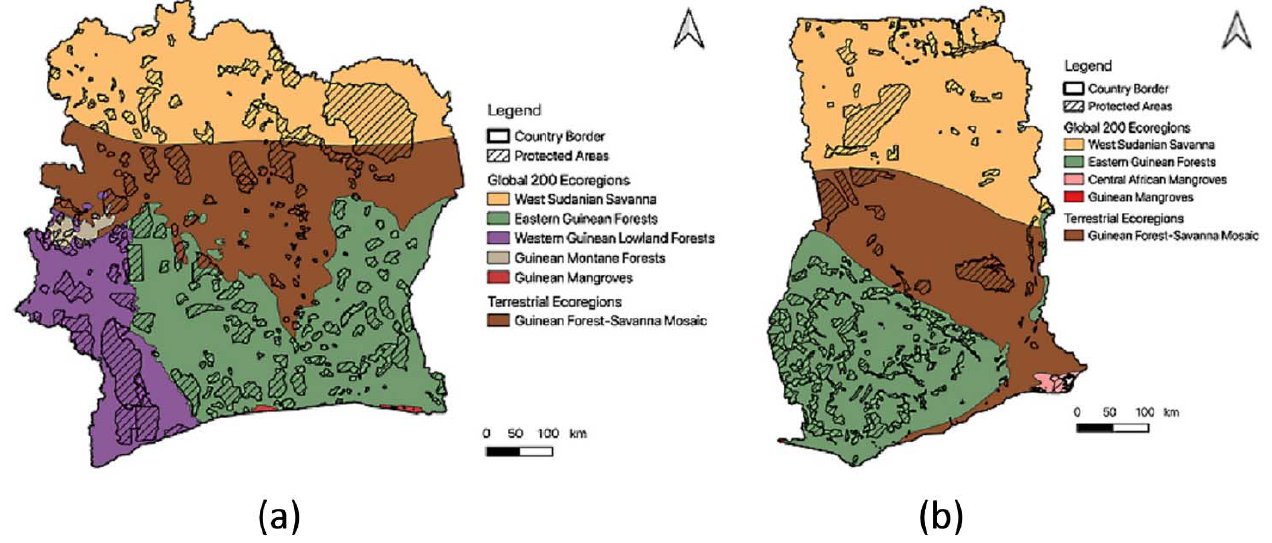
Figure 1. The ecoregions and protected areas of ( a ) Côte d’Ivoire and ( b ) Ghana, West Africa. Table 3. The comparison index (CI) for all protected areas (IUCN PA categories, those without assigned categorizations (not reported) and World Heritage Sites or UNESCO MAB reserves (not applicable) and their percentage land areas of the ecoregions in Ghana and Côte d’Ivoire. Blue highlighting indicates good representation (CI > 1), * = Global 200.